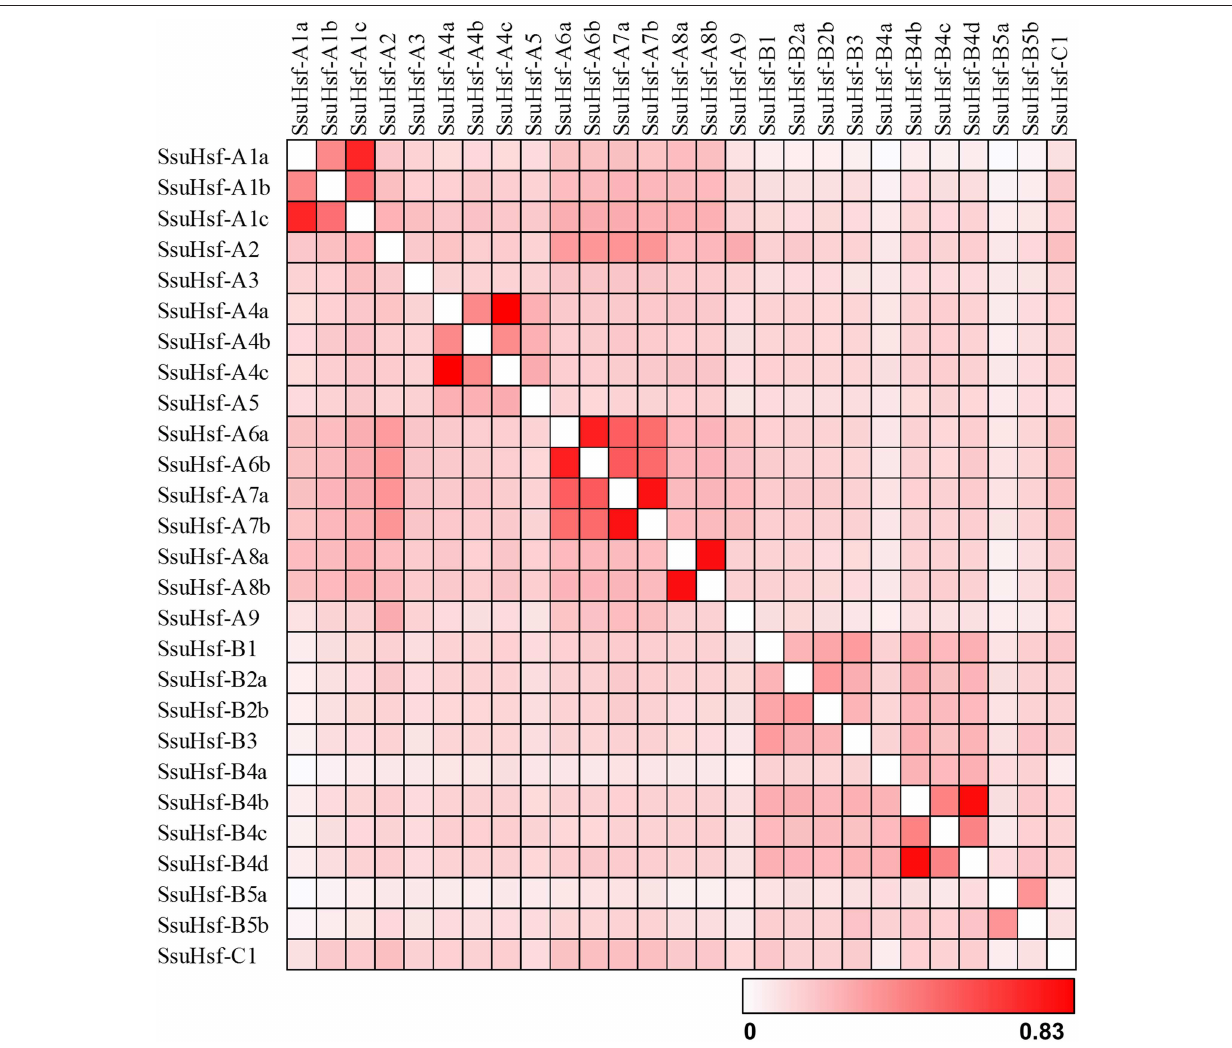
Frontiers in Plant Science |